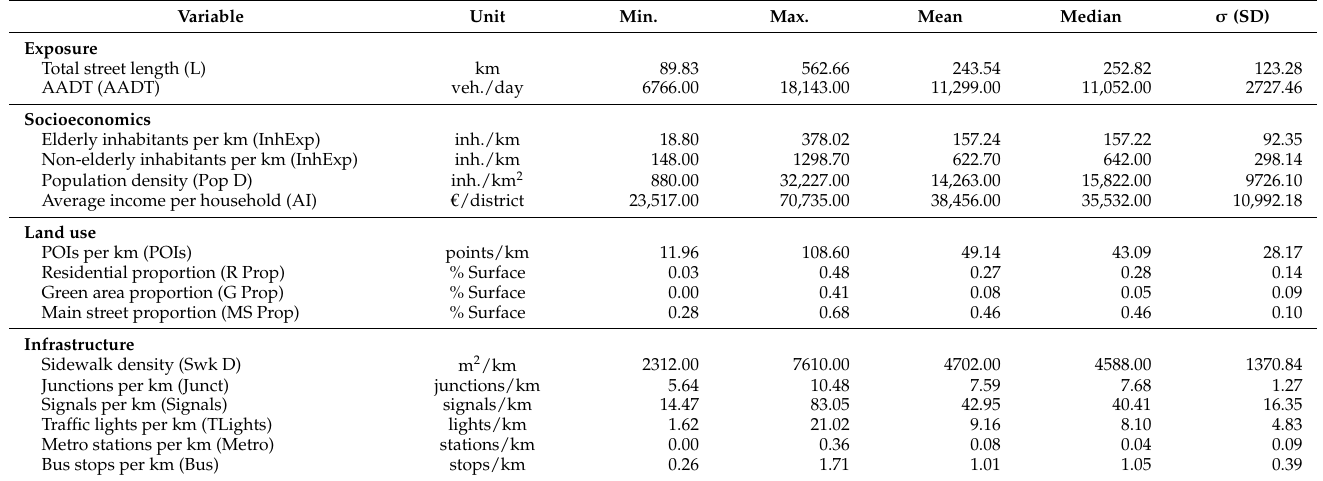
Figure 4. Sliding window method applied to Madrid case study in the period 2006–2018. Table 1. Main statistics of the built environment variables considered in the research by type (land use, socioeconomic, and